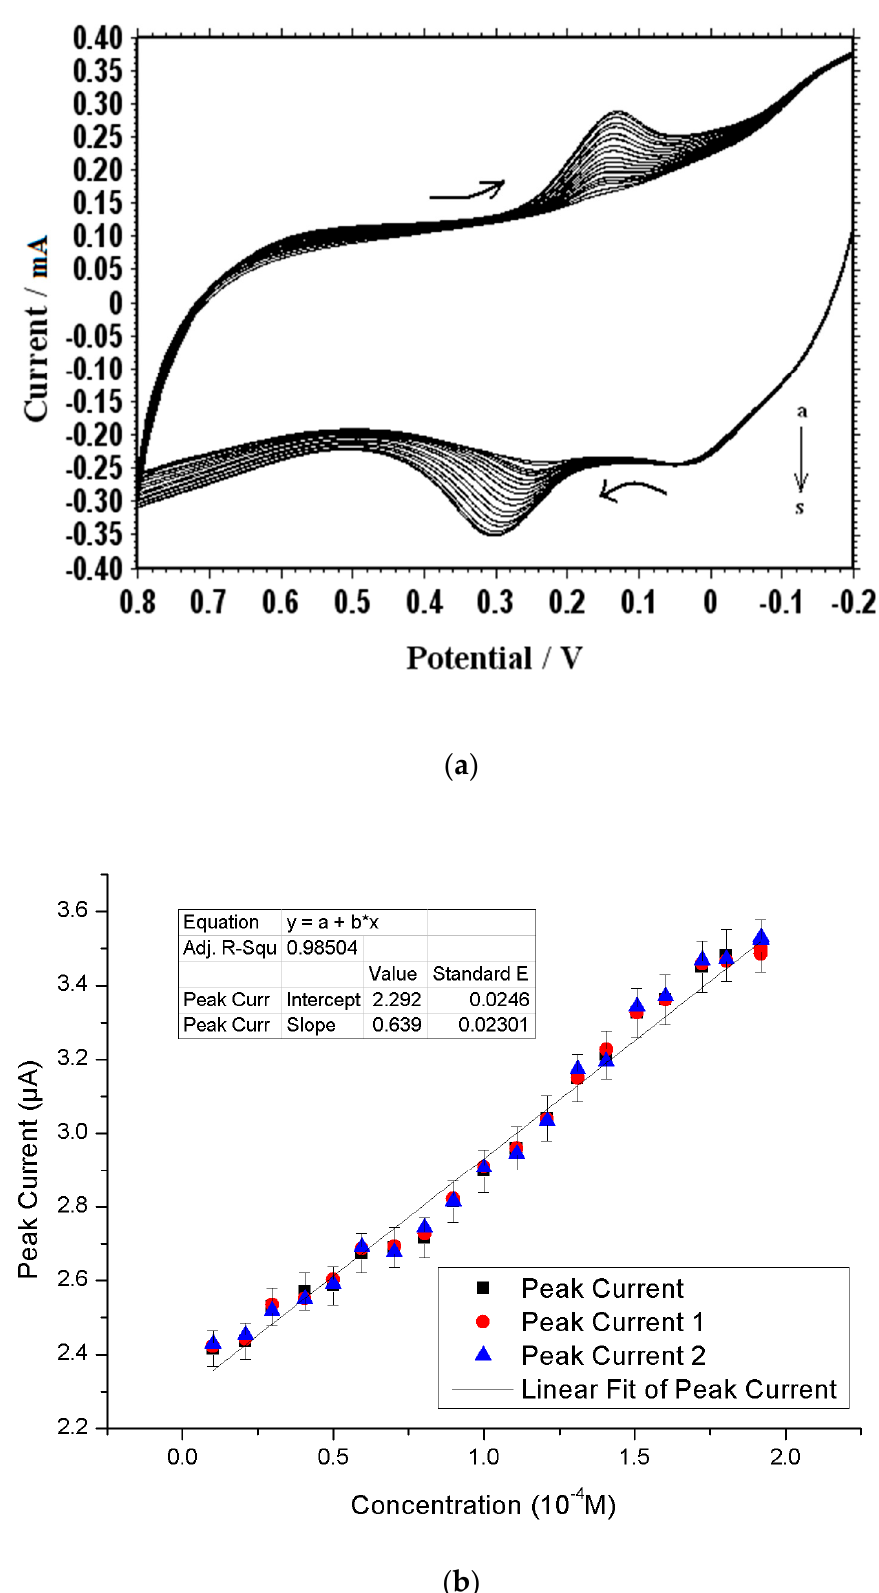
Figure 6. Effects of different concentrations of dopamine (DA): ( a ) Cyclic voltammograms of DA at different concentration (a-s; 0.1 to 1.9 × 10 − 4 M) in 0.1 M PBS (pH 7.0): Scan rate 100 mV ∙ s − 1 ; ( b ) Effect of different concentrations of DA on the oxidation peak current at the PMCPE.